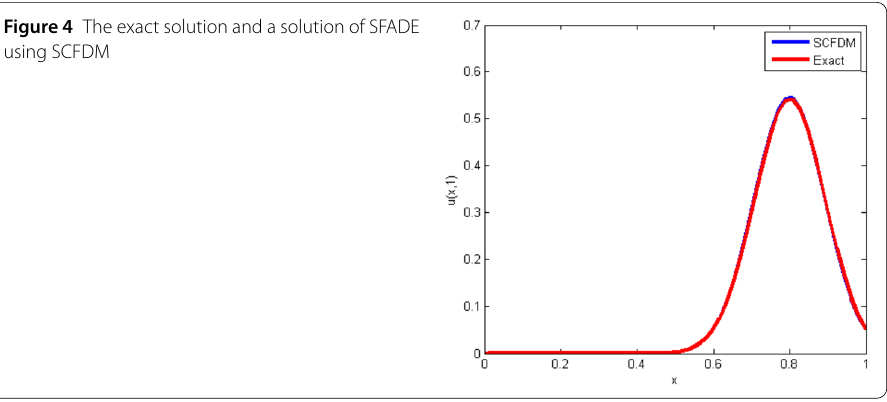
Figure 4 The exact solution and a solution of SFADE using SCFDM